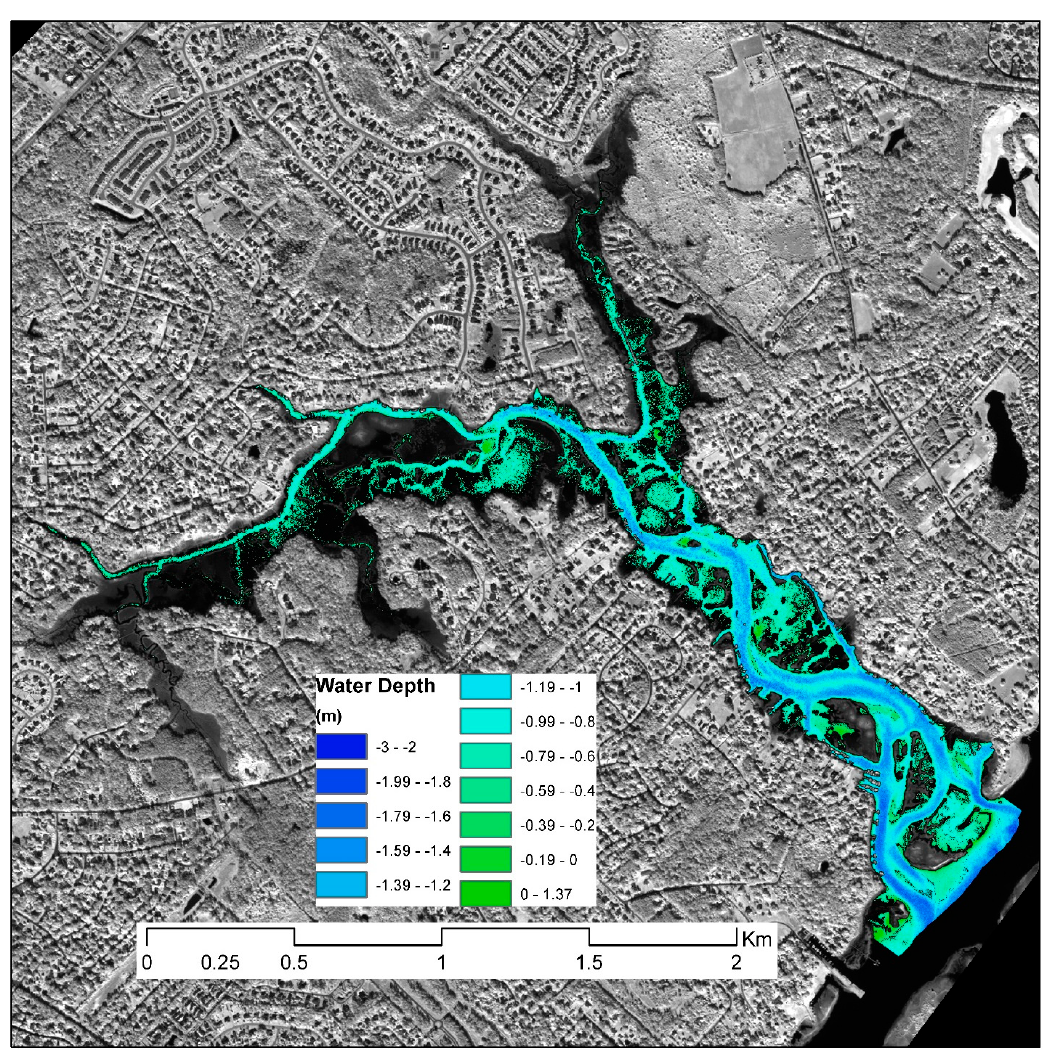
Figure 10. Derived bathymetry for the Pages Creek study area.